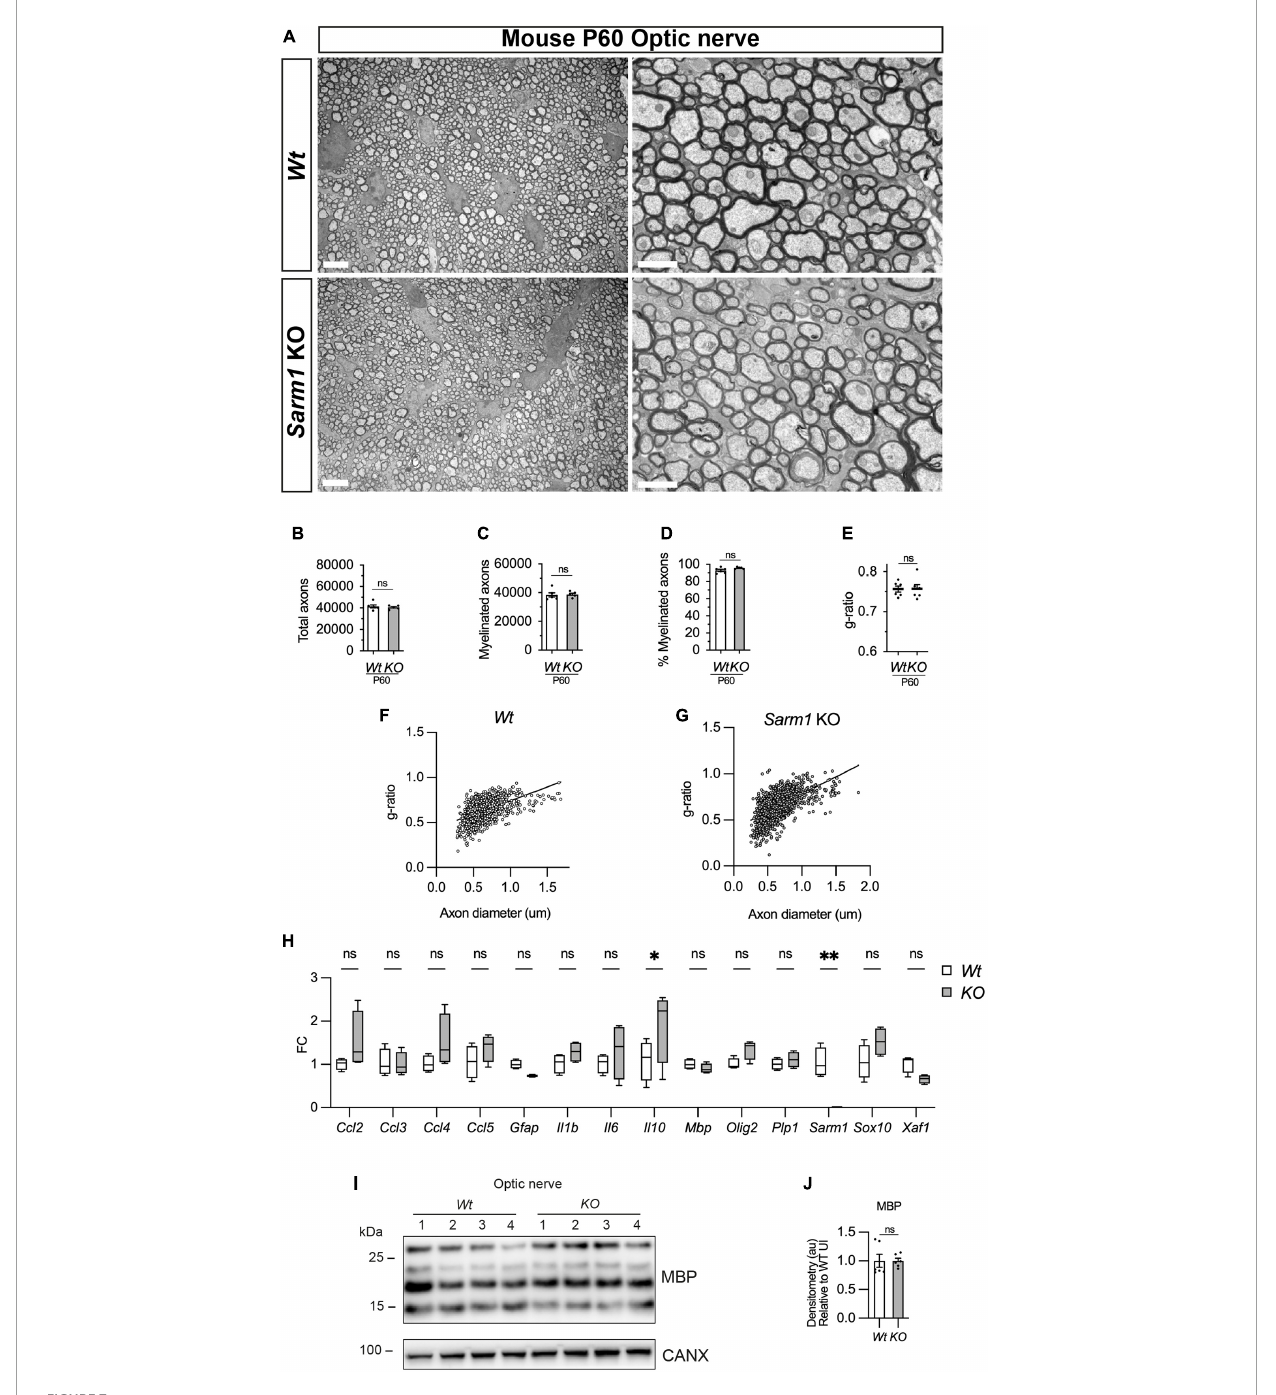
FIGURE7 Optic nerve myelination is normal in Sarm1 null mice. (A) Representative electron micrographs taken at x 3,000 (left hand side panels) and x 12000 (right hand side panels) magnification from adult Wt and Sarm1 KO optic nerves at postnatal day 60 (P60). There are no ultrastructural differences in the optic nerves of Sarm1 KO compared to those of Wt animals. Scale bar 5 µ m (x 3,000) and 2 µ m (x 12,000). (B) The total number of axons quantified per optic nerve profile are not significantly different between Wt , 41422 ± 1375 and Sarm1 KO, 40484 ± 786 (mean and SEM, n = 6 Wt ; n = 5 KO; p = 0.9307). (C) The number of myelinated axons quantified in Wt , 38457 ± 1441 and Sarm1 KO, 38782 ± 852.9 optic nerves is similar (mean and SEM, n = 6 Wt ; n = 5 KO; p = 0.4286). (D) The percentage of myelinated axons quantified in Wt , 92.8 ± 1.2 and Sarm1 KO, 95.9 ± 0.5 optic nerves is not significantly different (mean and SEM, n = 6 Wt ; n = 5 KO; p = 0.0736). (E) Myelin sheath thickness as depicted by g-ratios is similar in both Wt , 0.757 ± 0.007 and Sarm1 KO, 0.757 ± 0.01 optic nerves (mean and SEM, n = 6; p = 0.9610). (F) Scatter plot of g-ratio as a function of axonal caliber in Wt optic nerves. (G) Scatter plot of g-ratio as a function of axonal caliber in Sarm1 KO optic nerves. (H) Relative mRNA expression for chemokine, oligodendrocyte and myelin genes in the P60 uninjured optic nerve of Wt and Sarm1 KO mice. All fold change values normalized to uninjured Wt optic nerve ( n = 4; ∗ p < 0.05, ∗∗ p < 0.01). (I) Representative western blot image of optic nerve protein extracts shows no difference in levels of MBP, between Wt and Sarm1 KO nerves. (J) There is no significant difference in MBP expression between Wt and Sarm1 KO optic nerves ( n = 6; p = 0.3939). The quantifications are normalized to the levels in uninjured Wt nerves, which are set as